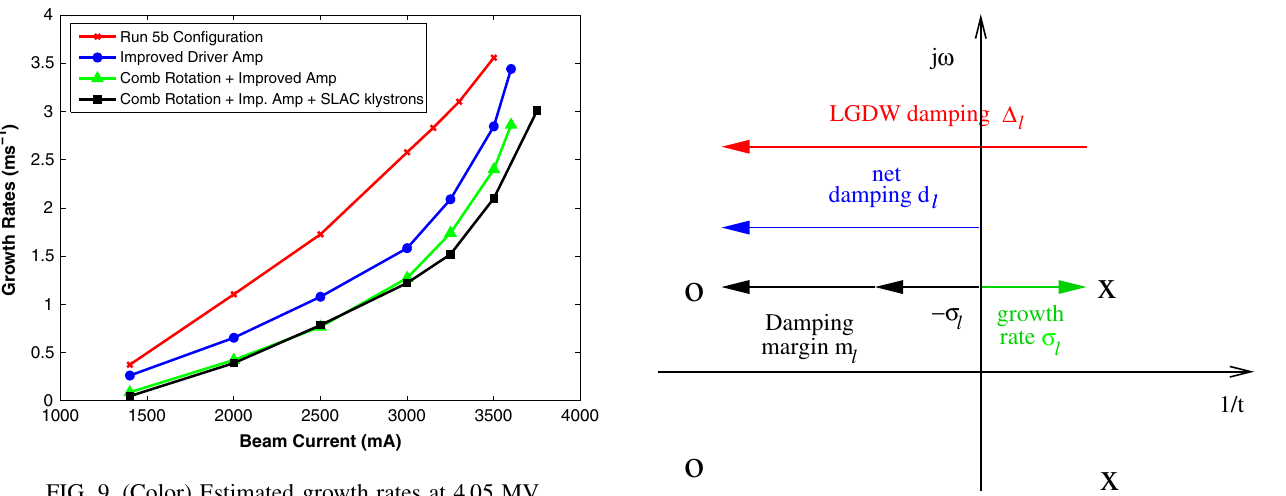
FIG. 9. (Color) Estimated growth rates at 4.05